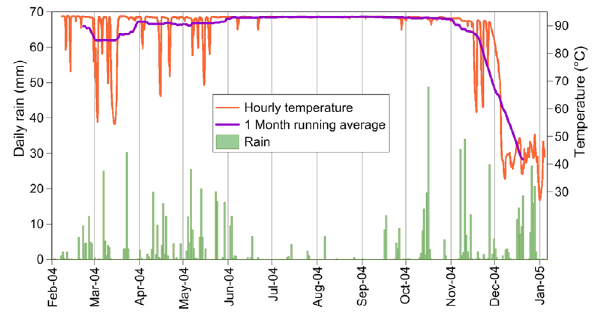
Figure 4. Top: hourly temperature (orange line) measured at 30 cm depth at FC2 station and its 1 month-running average (purple thick line); bottom: monthly rainfall amounts (green bars). Data refers to the period from February to December 2004.